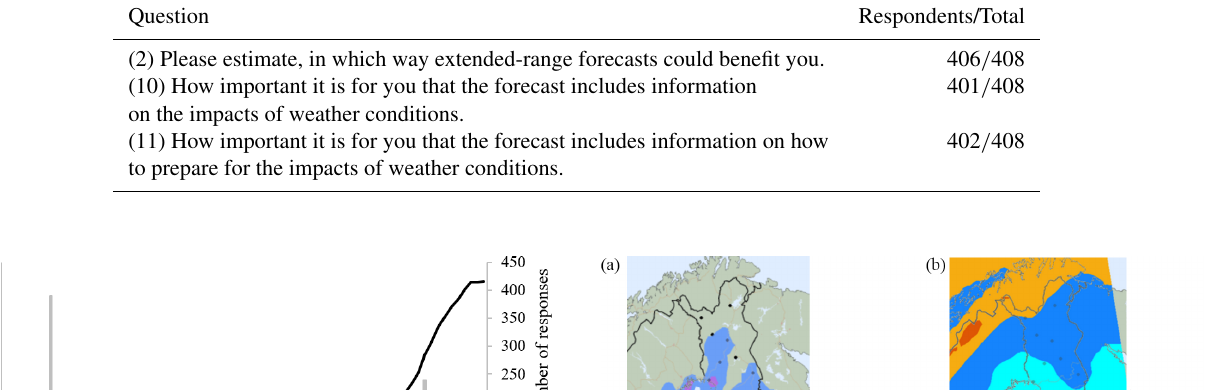
Table 1. Questions from the survey about how users estimate to benefit of the extended-range forecast products.